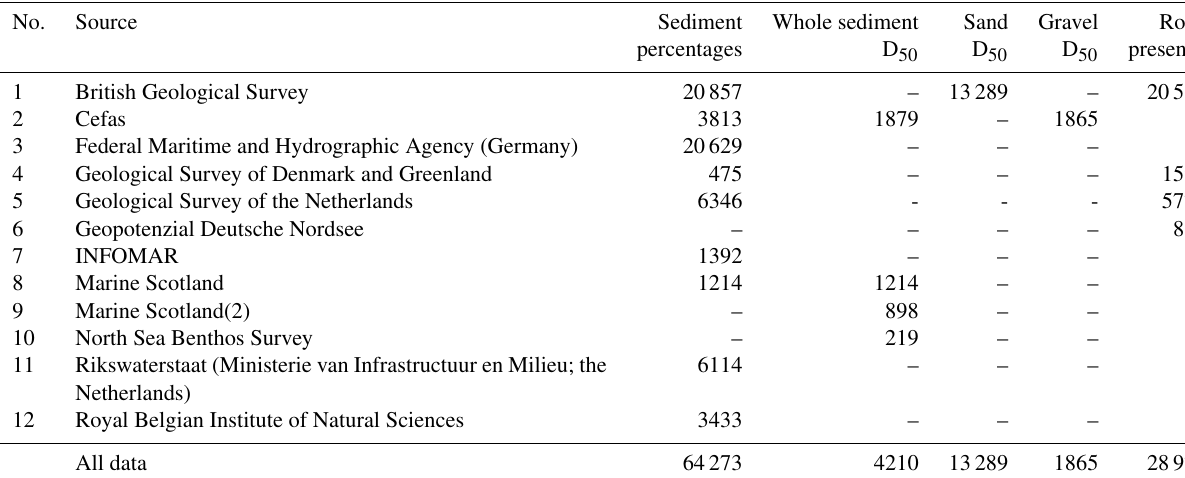
Table 2. Summary of data sources used in sediment analysis. Datasets 1 (http://www.bgs.ac.uk/geoindex/wms.htm) and 8 (http://www.vliz. be/vmdcdata/nsbs/) were open access. Datasets 3, 4, 5, 9, 10 and 12 were available from the transnational database of North Sea sediment data (Valerius et al., 2015), which is a collation of data compiled by the EMODnet-Geology (http://www.emodnet.eu/geology), TOLES (http://www.belspo.be/belspo/brain-be/projects/TILES_en.PDF) and AufMod (http://www.kfki.de/de/projekte/aufmod) projects. Datasets